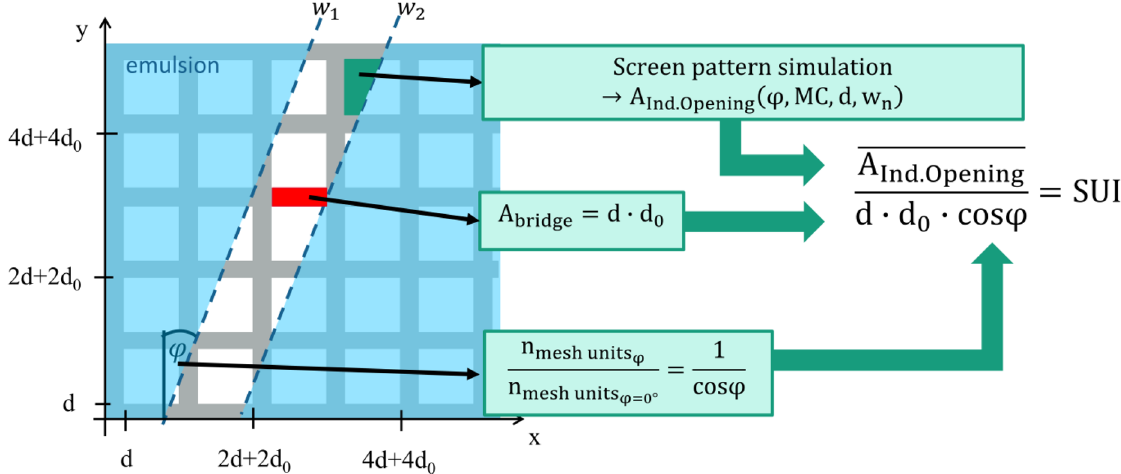
Figure 2. Definition of the screen utility index SUI, describing the relationship between the area of individual openings and the area of individual mesh bridges weighted by the amount of mesh units per screen opening